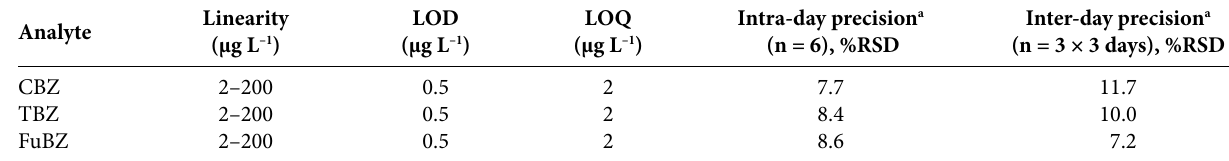
Table 1: Figures of merit of the proposed method for the determination of the benzimidazole fungicides in honey samples Analyte